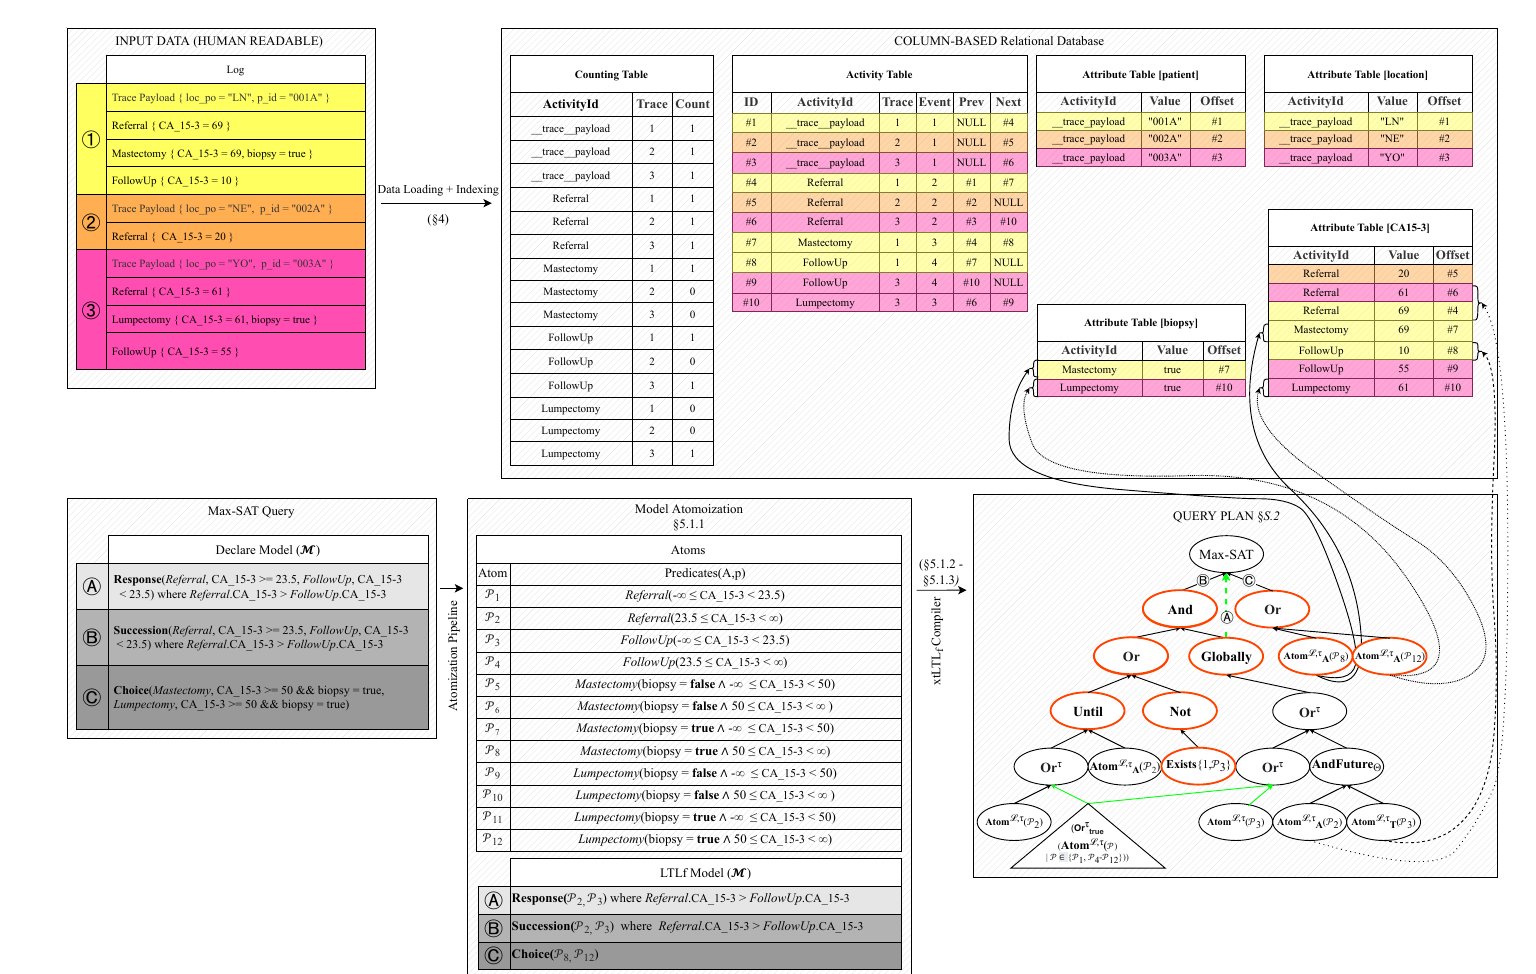
Figure 2. KnoBAB Architecture for Breast Cancer patients. Each trace (cid:192) – (cid:194) represents one single patient’s clinical history, represented with unique colouring, while each Declare clause A – C prescribes a temporal condition that such traces shall satisfy. Please observe that the atomisation process does not consider data distribution but rather partitions the data space as described by the data activation and target conditions. In the query plan, green arrows indicate access to shared sub-queries as in [9], and thick red ellipses indicate which operators are